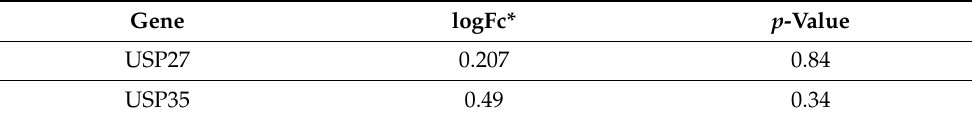
Table 2. Upregulation of deubiquitinases in TQ-treated Jurkat cells as compared with untreated